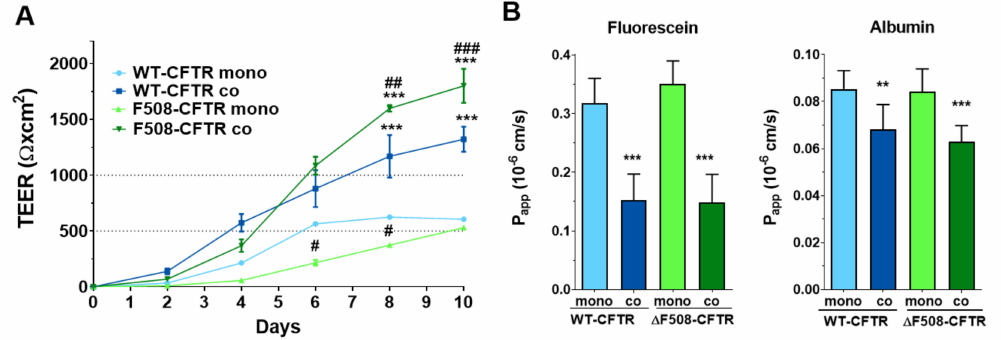
Figure 1. Transepithelial electrical resistance (TEER) ( A ) and permeability values (apical to basal direction) ( B ) of cystic fibrosis bronchial epithelial (CFBE) monocultures or co-cultures with endothelial cells. Values are presented as means ± SD, n = 4 / group. Statistical analysis: 2-way ANOVA and Bonferroni test. ** p < 0.01, *** p < 0.001 compared to the monocultures; # p < 0.05, ## p < 0.01, ### p < 0.001 compared to the respective wild-type